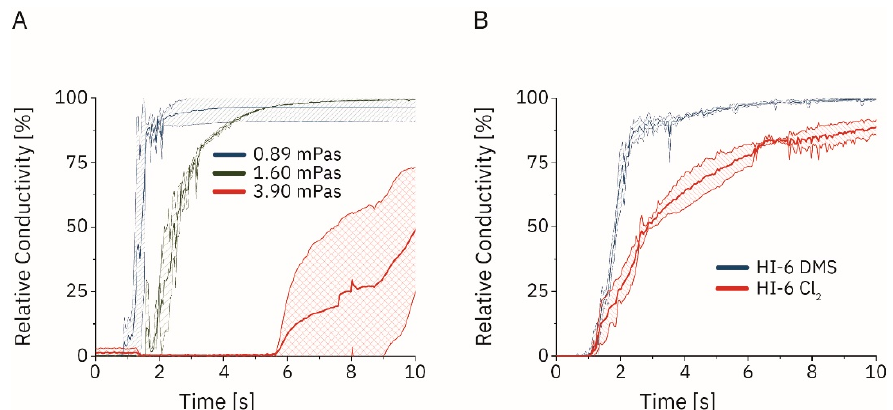
Figure 4. ( A ) Dissolution of sodium dihydrogen phosphate dihydrate in water and glycerol solu- tions with increasing dynamic viscosities ( n = 3; introduced in Figure 1C). ( B ) Dissolution of HI-6 dimethyl sulfonate (DMS) and HI-6 dichloride (Cl 2 , n = 3; T = 25 °C) in aqueous solutions containing 0.33 mg mL − 1 atropine.